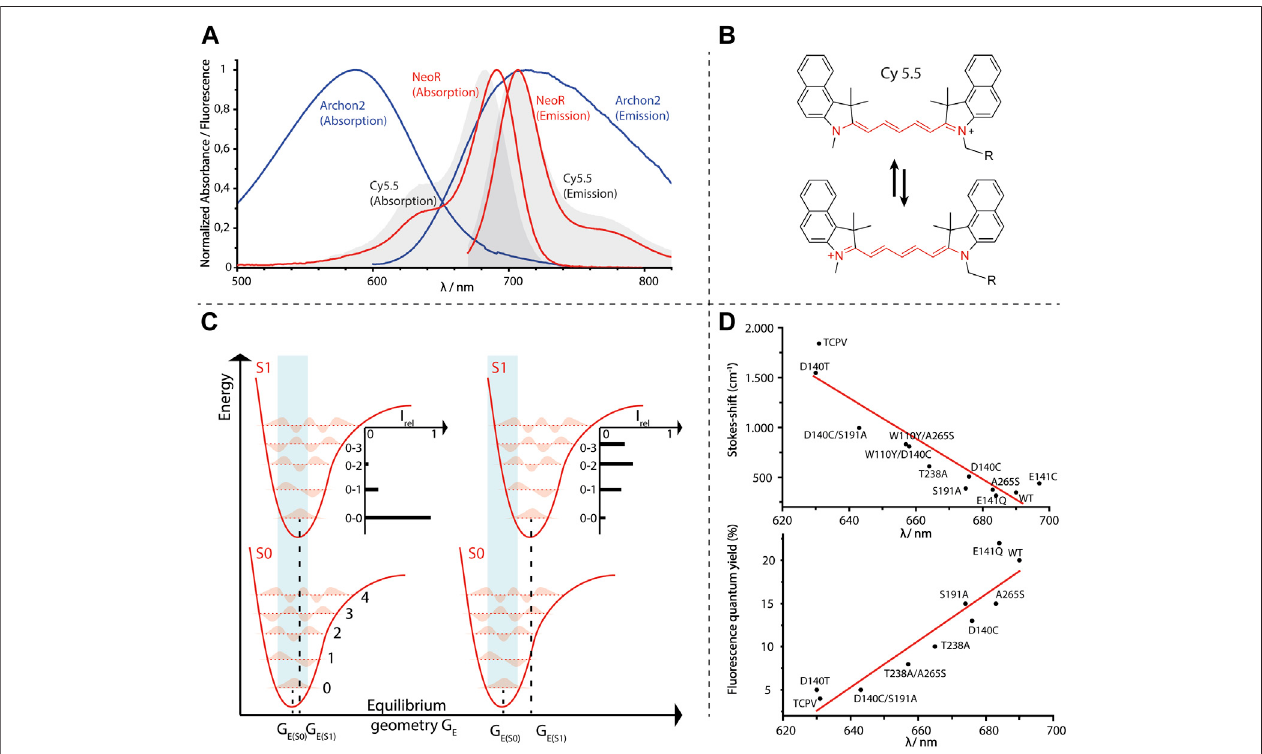
FIGURE5|(A) Normalizedabsorption-andemission-spectraofArch3-derivedvoltagesensorArchon2[A.Silapetere(HumboldtUniversityBerlin(Penzkoferetal., 2020)], NeoR and the fl uorescence dye Cy 5.5. (B) Structure of symmetric cyanine dye Cy 5.5 with resonance formula representing the “ cyanine-limit ” of fully charge- delocalization(red). (C) Energydiagramoflight-absorption (light-bluearea) ofachromophorewitheitherminor (left)orlargergeometricalchanges(right)uponexcitation. Five vibronic-states for each electronic potential are shown. Different transition probabilities according to the Franck-Condon principle result an